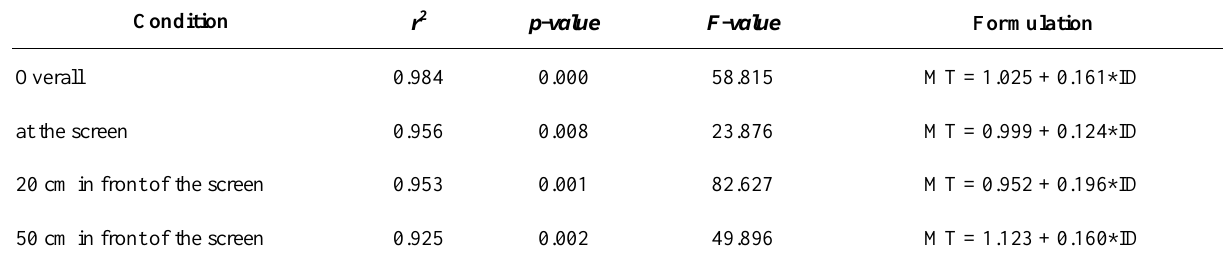
Regression results of hand movement time